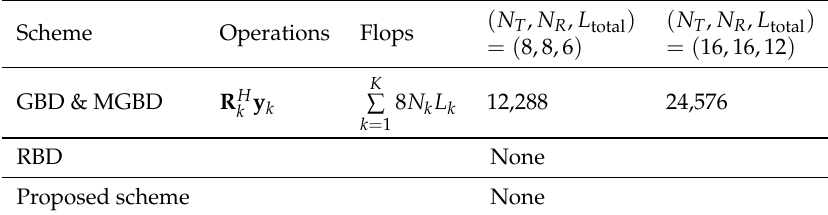
Table 1. Computational complexity of post-coding at receiver.